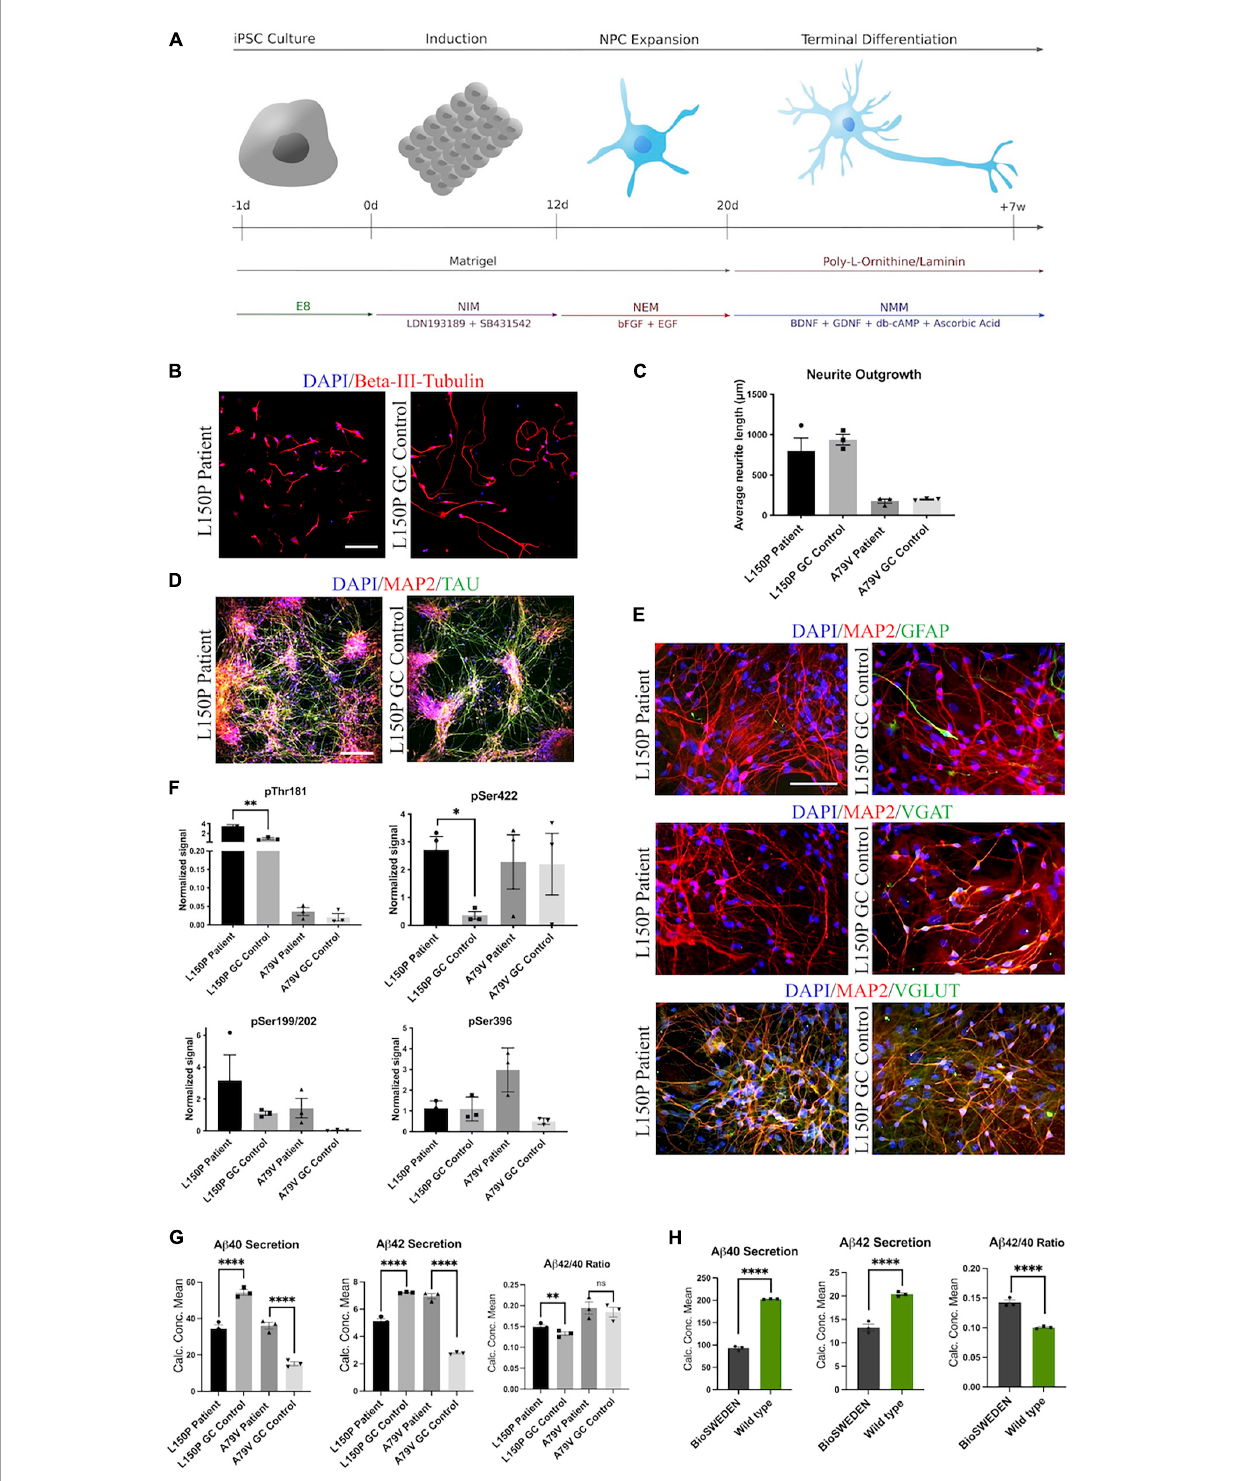
FIGURE1 Generation and characterization of hiPSC derived neurons. (A) Schematic overview of the neural differentiation protocol. (B) Neurite outgrowth analysis via ICC expression of Beta-III-tubulin. Scale bar 100 µ m. (C) Quantitative assessment of average neurite outgrowth. (D) Representative ICC images of neuronal markers MAP2 and TAU. Scale bar 100 µ m. (E) Representative ICC images of MAP2, astrocytic marker GFAP, GABAergic neuron marker VGAT, and glutamatergic neuron marker VGLUT. Scale bar 50 µ m. (F) Quantitative assessment of Tau phosphorylation (all four isoforms) - pThr181, pSer422, pSer199/202, and pSer396. (G) Quantitative assessment of A β 40 and 42 secretion, and A β 42/40 ratio in L150P and A79V hiPSC derived neurons. (H) Quantitative assessment A β 40 and 42 secretion, and A β 42/40 ratio in K3P53 and BioSweden hiPSC derived neurons. Results are displayed as mean ± standard error of the mean (SEM) from three replicates. Significance levels are indicated by ∗ p < 0.05, ∗∗ p < 0.01, and ∗∗∗∗ p <